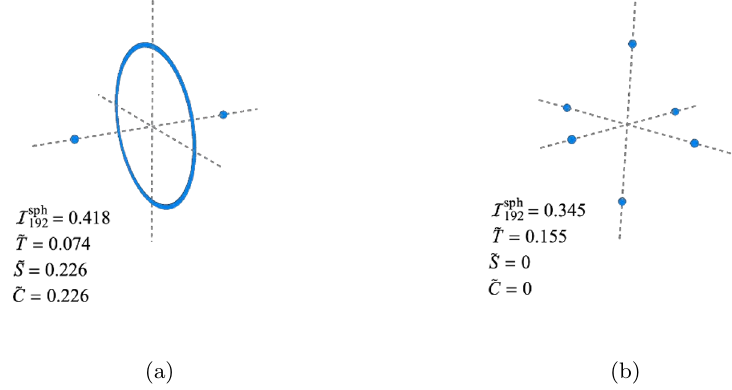
Figure 4 . Event con(cid:12)gurations that (nearly) saturate traditional event shape observables. The blue points represent the particles in momentum space. (a) An anisotropic event with small thrust. The thrust is minimized when the summed momentum of the ring ( p ring ) is related to the momenta of each of the individual particles p part by p part = 4 p ring . (b) A six particle con(cid:12)guration that (cid:25) saturates the spherical bound for both sphericity and the C